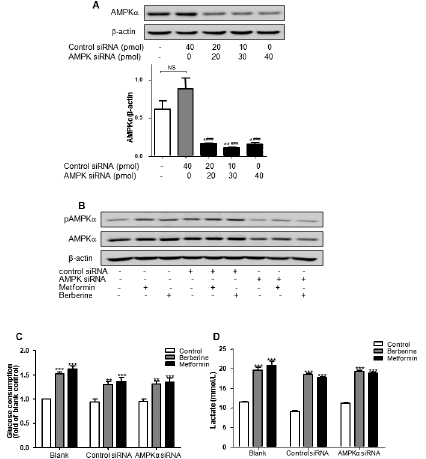
Figure 7. Effects of berberine on glucose consumption and lactate release upon AMPK a 1/ a 2 silencing in HepG2 hepato- cytes. A: HepG2 hepatocytes were seeded in 24-well plates, and transfected with various doses of scrambled siRNA and/or AMPK a 1/ a 2 siRNA for 24 h. The protein level was examined by Western blot. Ratio of AMPK a to b -actin was quantified in 3 independent experiments per condition. It had been found that AMPK a 1/ a 2 siRNA at 30 pmol/well most effectively suppressed the expression of AMPK a . * P , 0.05 and ** P , 0.01 vs . blank control; ### P , 0.001 vs . control siRNA. B, C and D: After transfection for 24 h, HepG2 hepatocytes were treated with berberine (20 m mol/L) or metformin (10 mmol/L) for another 24 h, followed by Western blot, glucose consumption and lactate concen- tration assay. Results are shown as means 6 SEM from at least three independent experiments; ** P , 0.01, *** P , 0.001 vs . control in corre- sponding group.